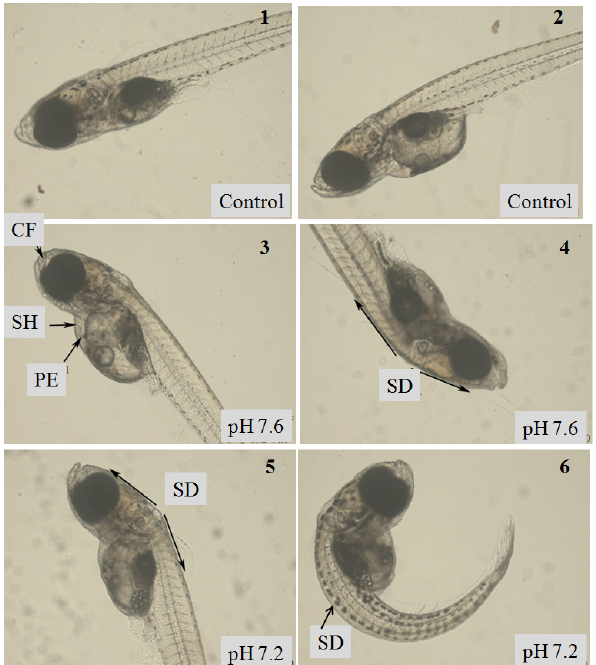
Figure 5. Morphological changes of medaka larvae exposed to three pHlevels. 1–2: Control-nNormal (pH8.2); 3–4: pH7.6 treatment; 5–6: pH7.2 treatment. SD: Spinal deformities; CF: Craniofacial de- formities; PE: Pericardial edema; SH: Stretched